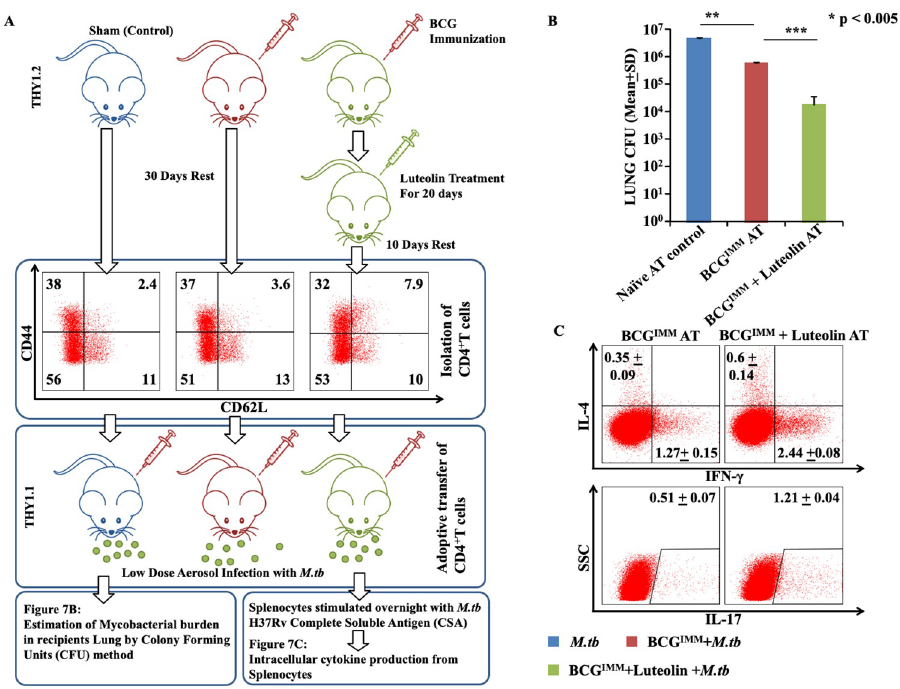
Fig 7. Adoptively transferred T cells from luteolin-treated and BCG-immunized mice confer improved protection against TB. (A) Experimental Layout: CD4 + T cells were isolated from congenic wild-type Thy1.2 mice immunized with BCG followed by luteolin treatment for 20 days and rested for 10 days. CD4 + T cells (10x10 6 ) were adoptively transferred into γ -irradiated (sub-lethal dose of 800 rads/mice) Thy1.1 congenic mice followed by infection with M . tb . Twenty days after infection, spleen and lungs were isolated. (B) CFUs were estimated from lung homogenates of the different groups. (C) Splenocytes were challenged with M . tb complete soluble antigen ex vivo. T cells were then stained for the intracellular cytokines IL-4 vs. IFN- γ and IL-17. Data represented as the mean ± STDEV values. Differences were considered significant at P < 0.05 using one way ANOVA. Out of twelve mice within each group, only 5 mice in the BCG immunized control group and 6 mice in the luteolin control group survived on day 20. � p < 0.05, �� p < 0.005, ��� p <